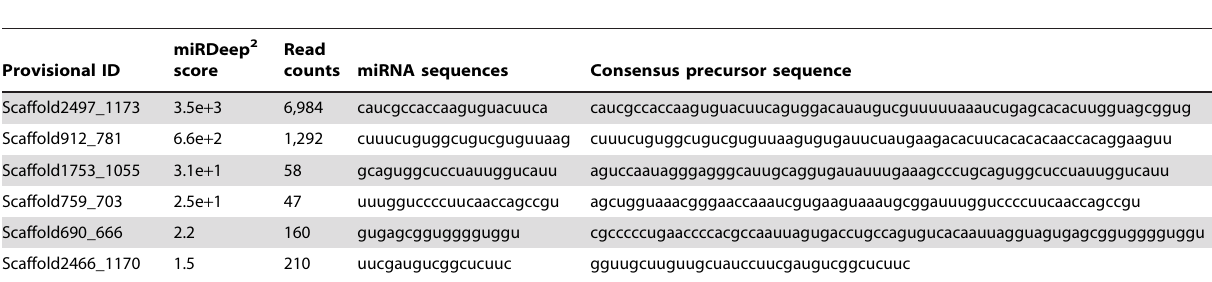
Table 3. Novel miRNA candidates identified from tube foot of sea